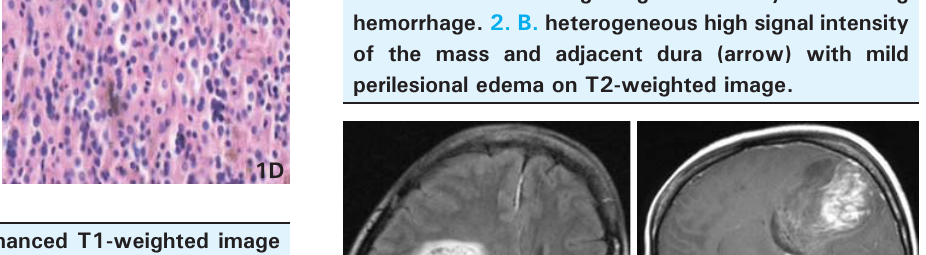
Figure 1. C. Contrast enhanced T1-weighted image shows heterogeneous enhancement of solid portion of the mass. Figure 1. D. Pathological specimen H&E stain (x 400) showing oval to round tumor cells arrange in small groups with abundant translucent cytoplasm.